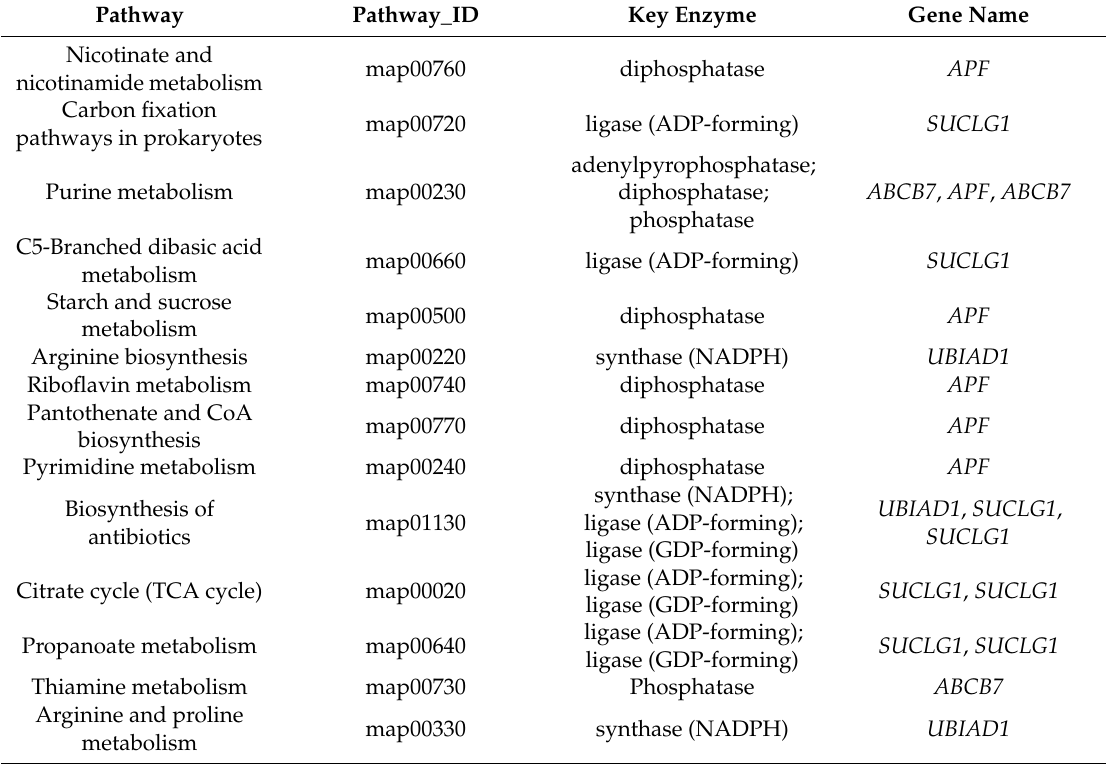
Table 5. KEGG pathway enrichment analysis of representative